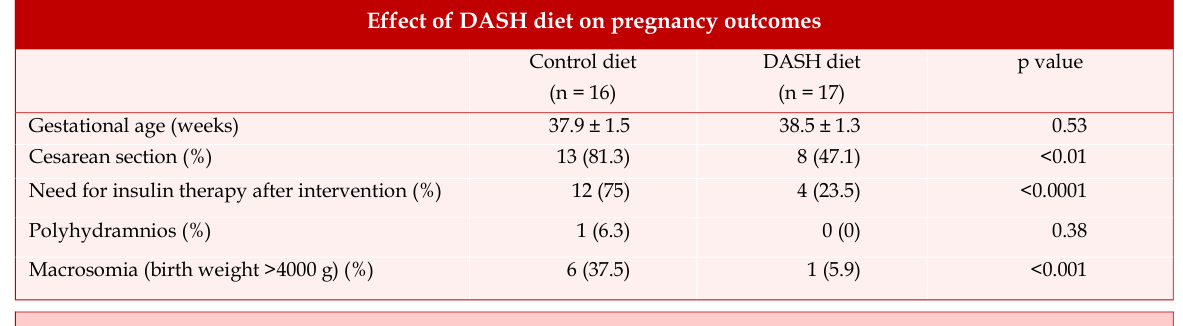
Effect of DASH diet on pregnancy outcomes